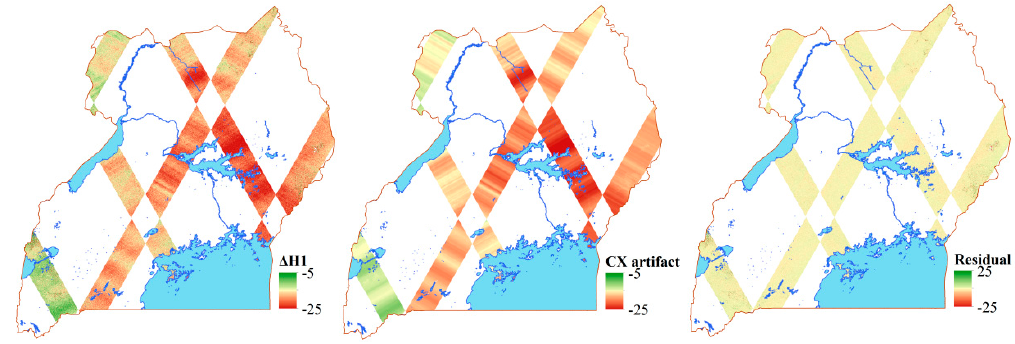
Figure 2. The height difference between the X- and C-band SRTM DEMs (left), the linear artifacts predicted by the GLM model (middle) and the residual noise (right).